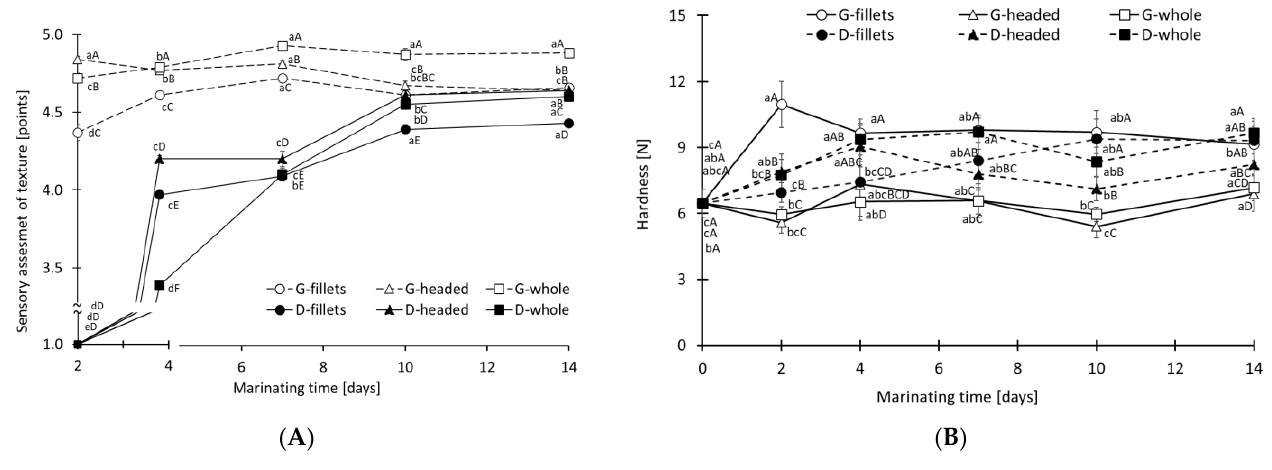
Figure 8. Effect of marinating method (G- — German, D- — Denmark) and degree of primary pro- cessing of Baltic herring (whole, headed, fillets) on ( A ) texture sensory evaluated and ( B ) hardness evaluated by TPA. a,b,c Results marked with the same lower case letter do not statistically differ by the influence of marinating time; A,B,C Results marked with the same capital letter do not statistically differ by the influence of the marinating method. For a better presentation of the results, a break (≈) in the Y axis was used.